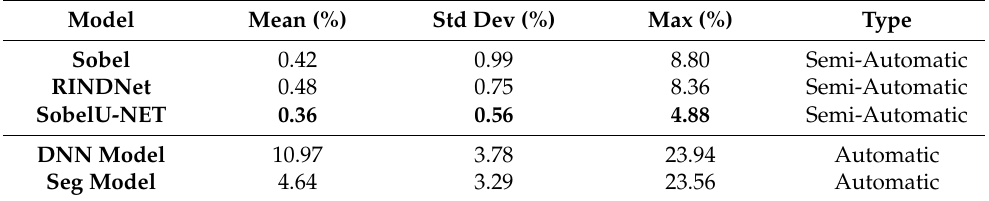
Table 2. Percentage of the mean, standard deviation and maximum error distance measured in pixels and standardized by the image diagonal. Results are for testing on the BCCT dataset. Best results are highlighted in